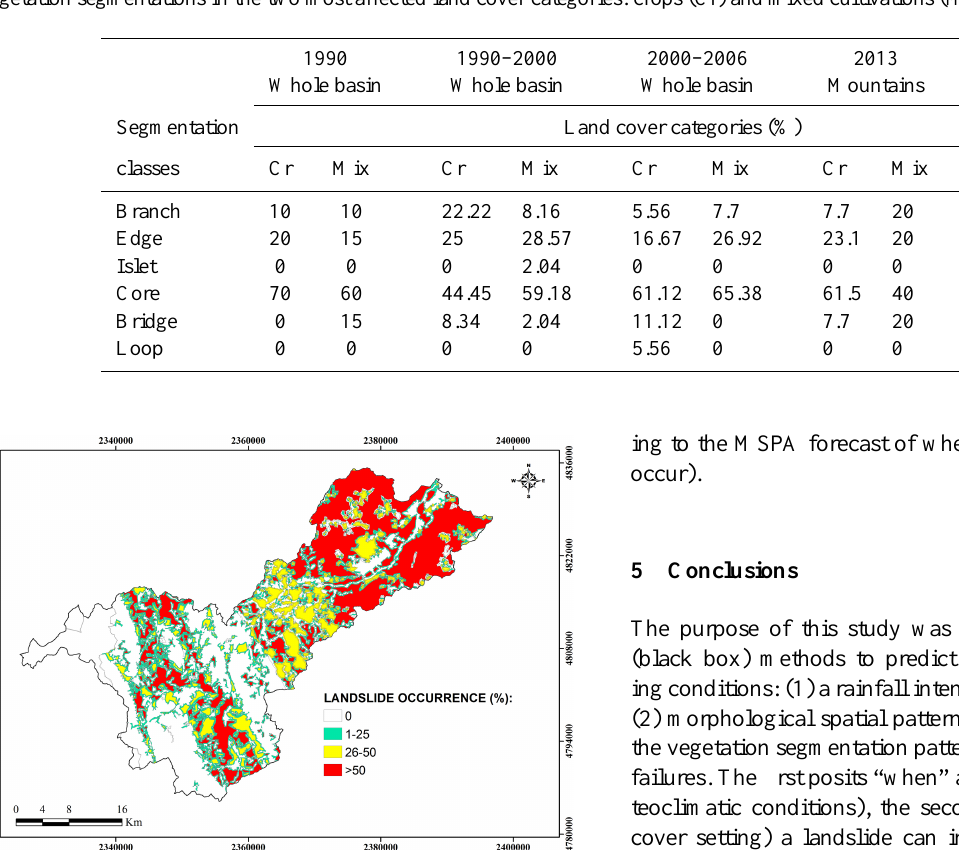
Table 2. Multitemporal MSPA analysis in the Esino watershed. Values represent the percentage of landslide occurrence over the different vegetation segmentations in the two most affected land cover categories: crops (Cr) and mixed cultivations (Mix).